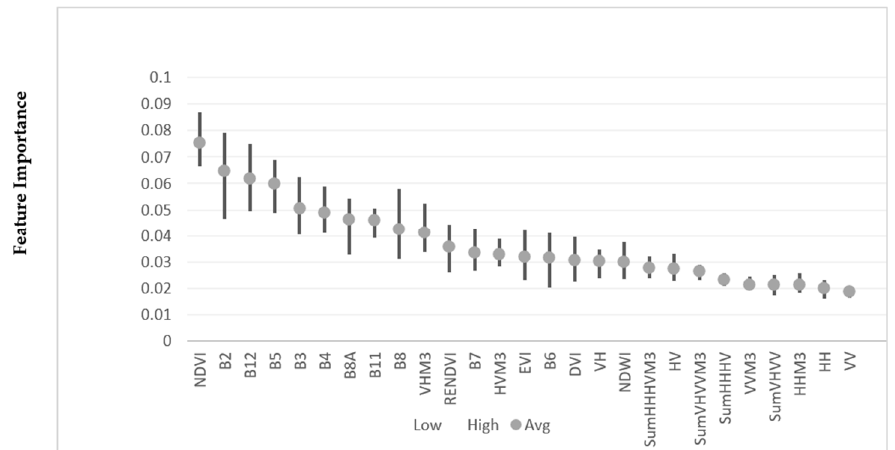
Figure 8. The variable importance of different bands, SAR backscattering coefficients, spectral indices, and polarimetric features on the final classification accuracy by the CRF classifier based on the Gini importance index.